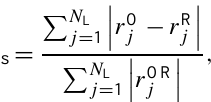
Fig. 3. Visual representation of Type I and II errors by density (top panel) and cumulative distribution (bottom panel) functions.